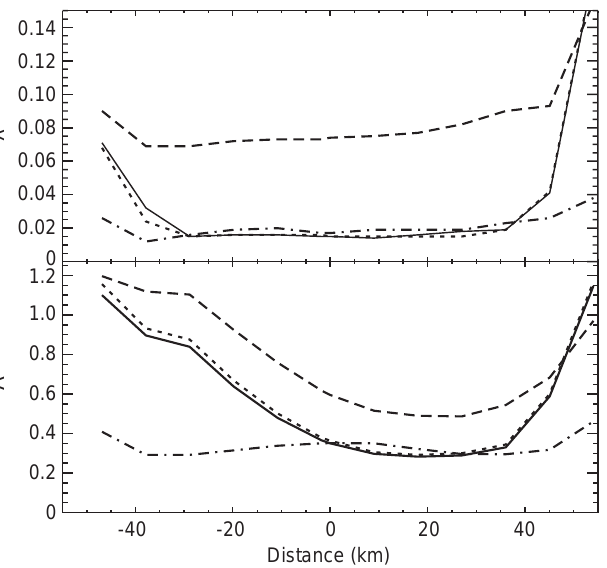
Fig. 3. Quality (cid:107) and reconstruction (cid:75) parameters for the Tromsø observation geometry with three stations pointed to a fixed reference point and the auroral arc moving through the reconstruction volume from north to south. The results of ART ( dashed line ), SIRT ( dotted line ), and MART ( solid line ) are shown. The dash-dotted line connects the MART results with the first estimate taken from the reconstruc- tion in the center of